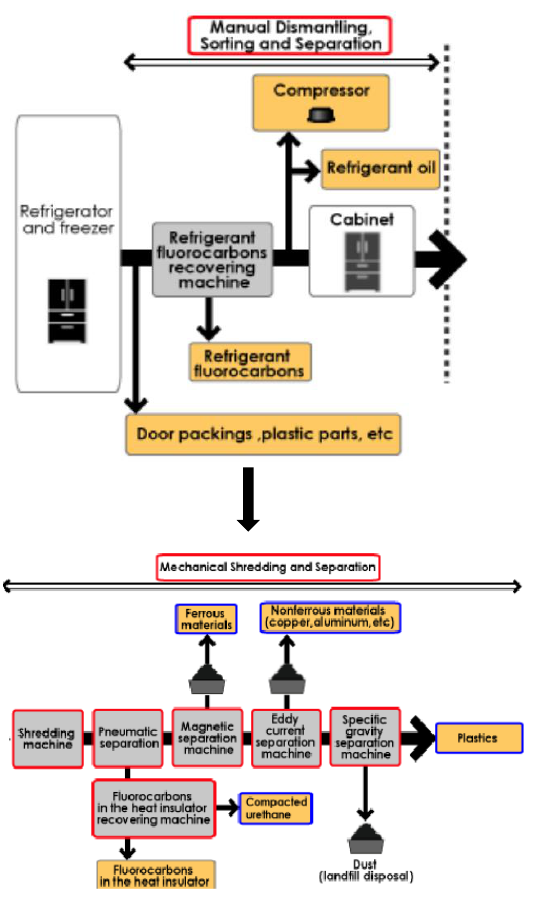
Figure 2. Recovery Stages of the Refrigerators Waste Materials [39].